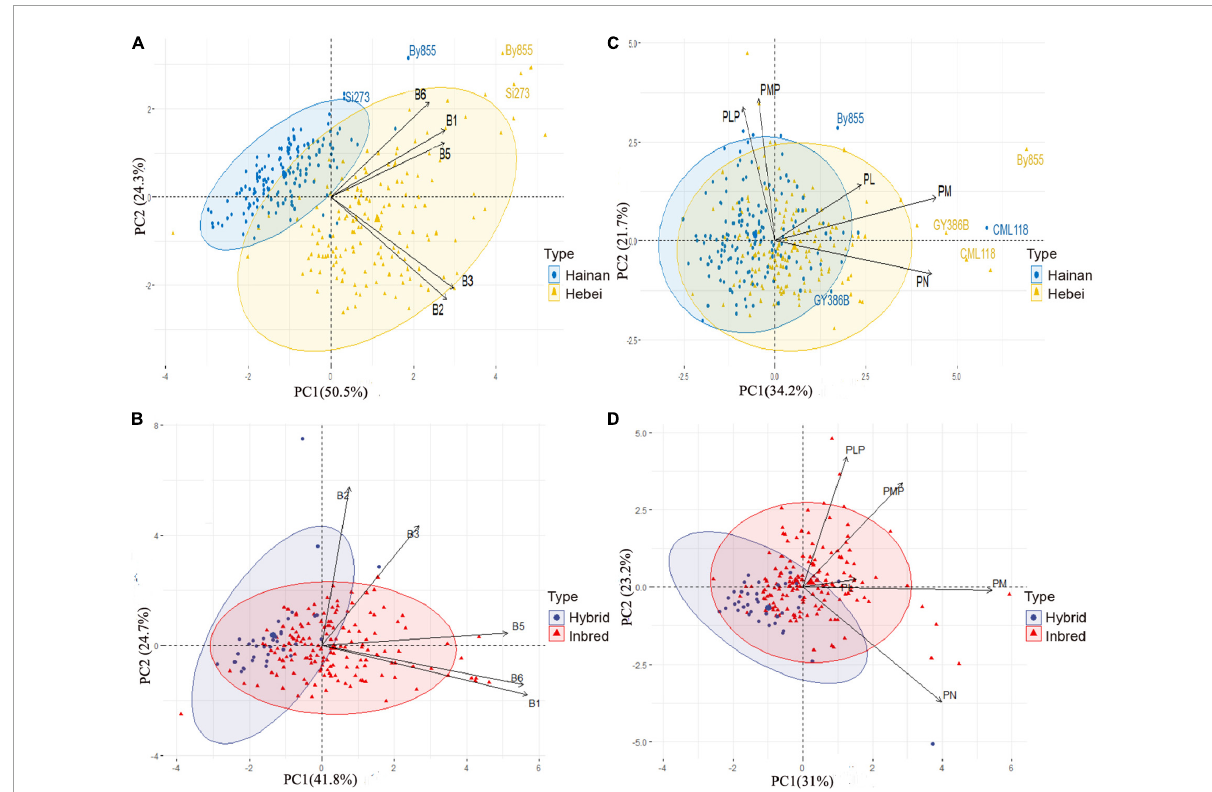
FIGURE3 Principal component analysis (PCA) of biplots for vitamin B contents of maize inbred lines: (A) Vitamin B1, B2, B3, B5, and total B6 between Hainan and Hebei. (B) Vitamin B1, B2, B3, B5, and total B6 between inbred and hybrid. (C) Derivatives of vitamin B6 between Hainan and Hebei. (D) Derivatives of vitamin B6 between inbred and hybrid lines. PC1 as x-axis; PC2 as y-axis. B1, thiamine; B2, riboflavin; B3, niacinamide; B5, pantothenic acid; and B6, total of pyridoxine and derivatives; PL, pyridoxal; PLP, pyridoxal 5’-phosphate; PM, pyridoxamine; PMP, pyridoxamine-5’-phosphate; PN, pyridoxine. Biplots were generated through scattering the germplasms based on location with the content of vitamins indicated as vectors and the relative proportions of variability in each variable are indicated by the relative lengths of specific vectors.